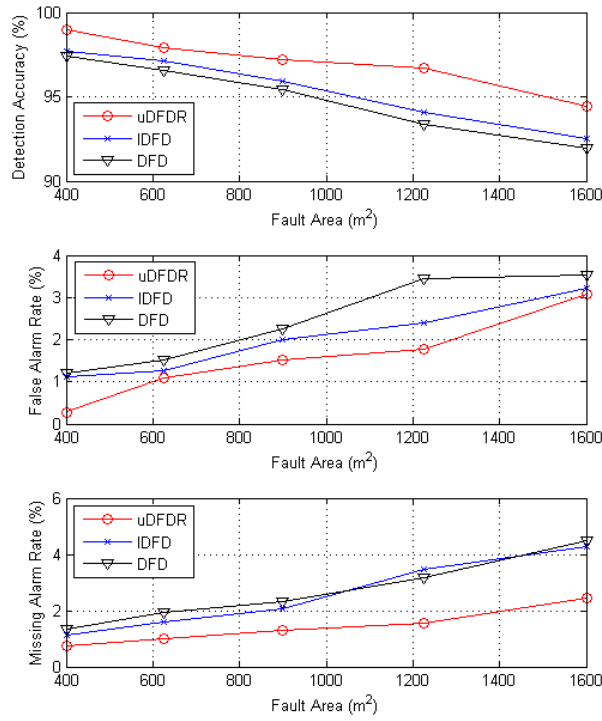
Figure 9. Detection effects under intensive fault conditions.